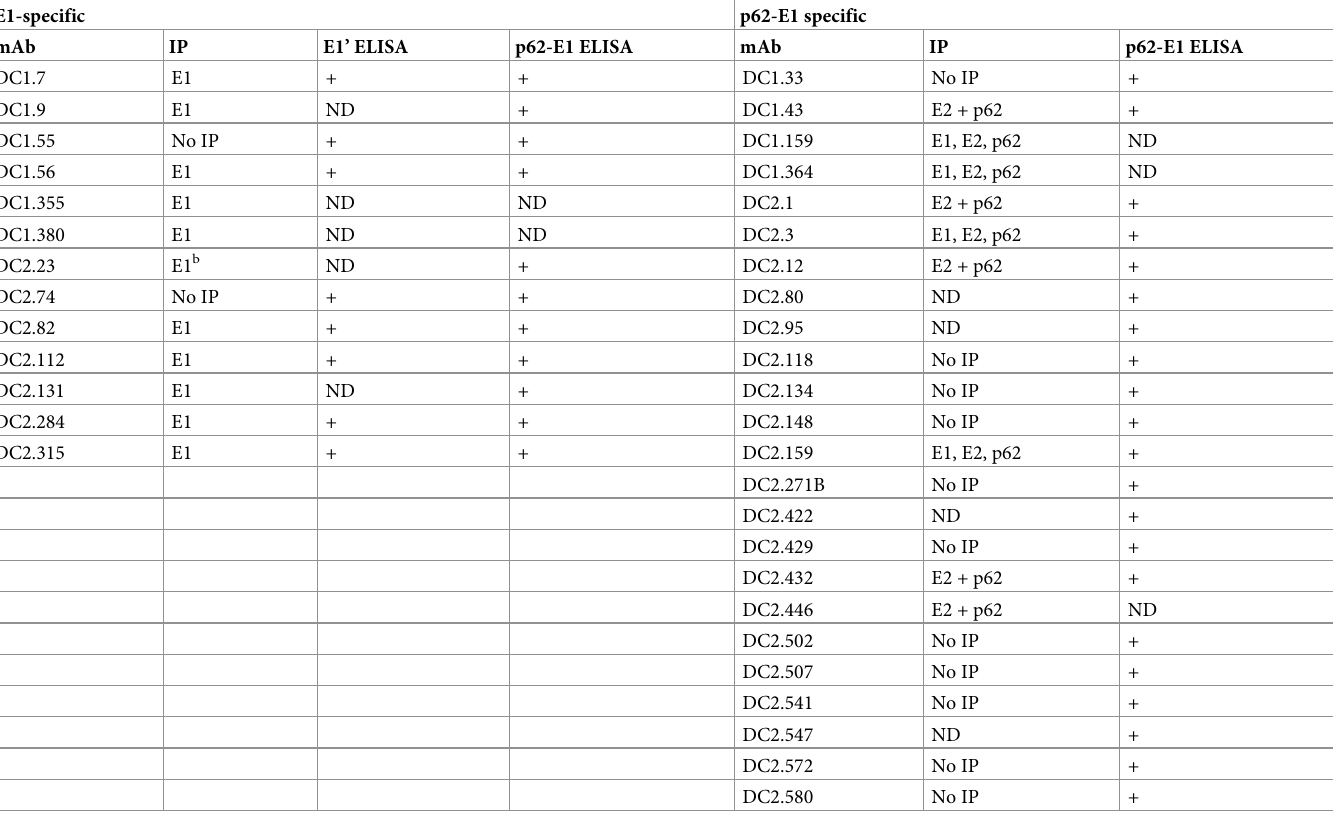
Table 1. Summary of immunoprecipitation (IP) and E1’ or p62-E1 ELISA results a .